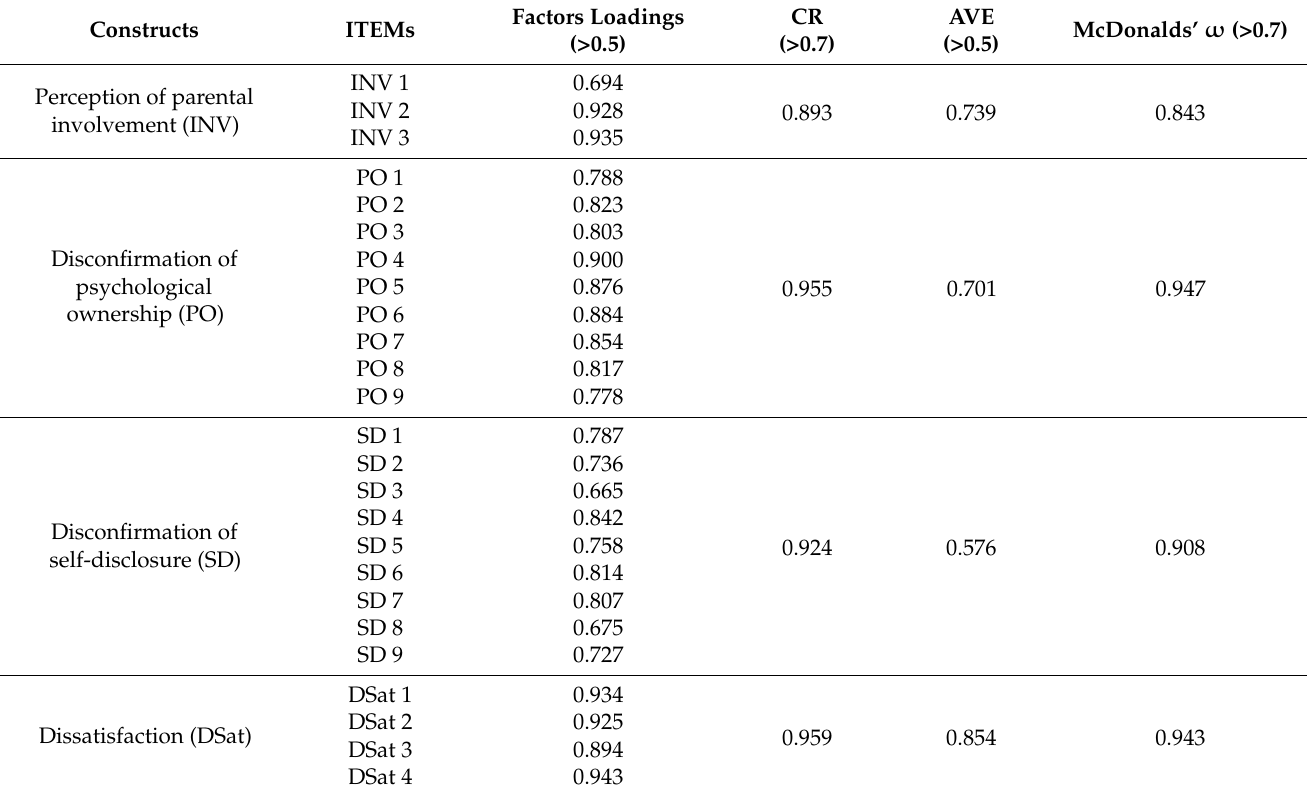
Table 2. Results of reliability and validity